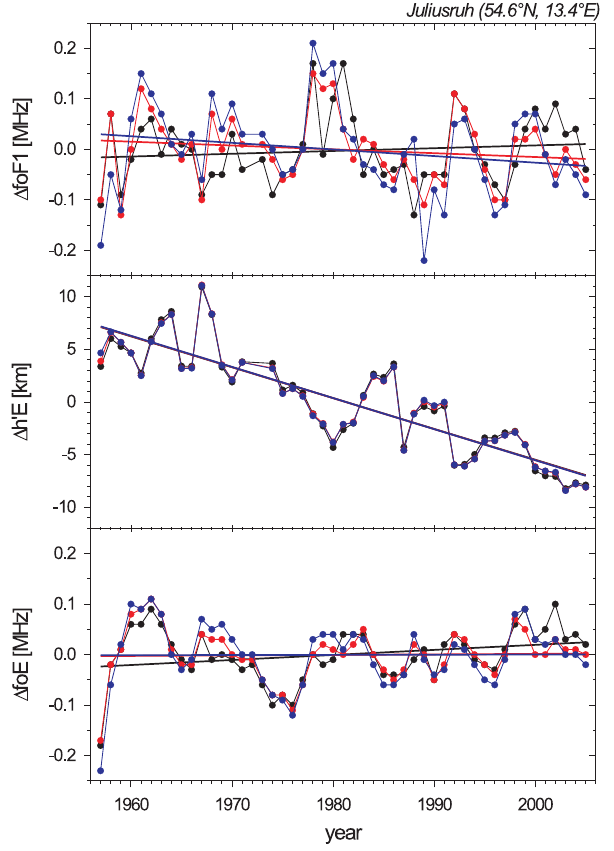
Fig. 3. Long-term trends of different ionospheric parameters ( foE , h’E , foF1 ) observed at the ionosonde station Juliusruh after elimi- nation of the solar and geomagnetic influences using different solar activity indices (R: black, F10.7: red, E10.7: blue).